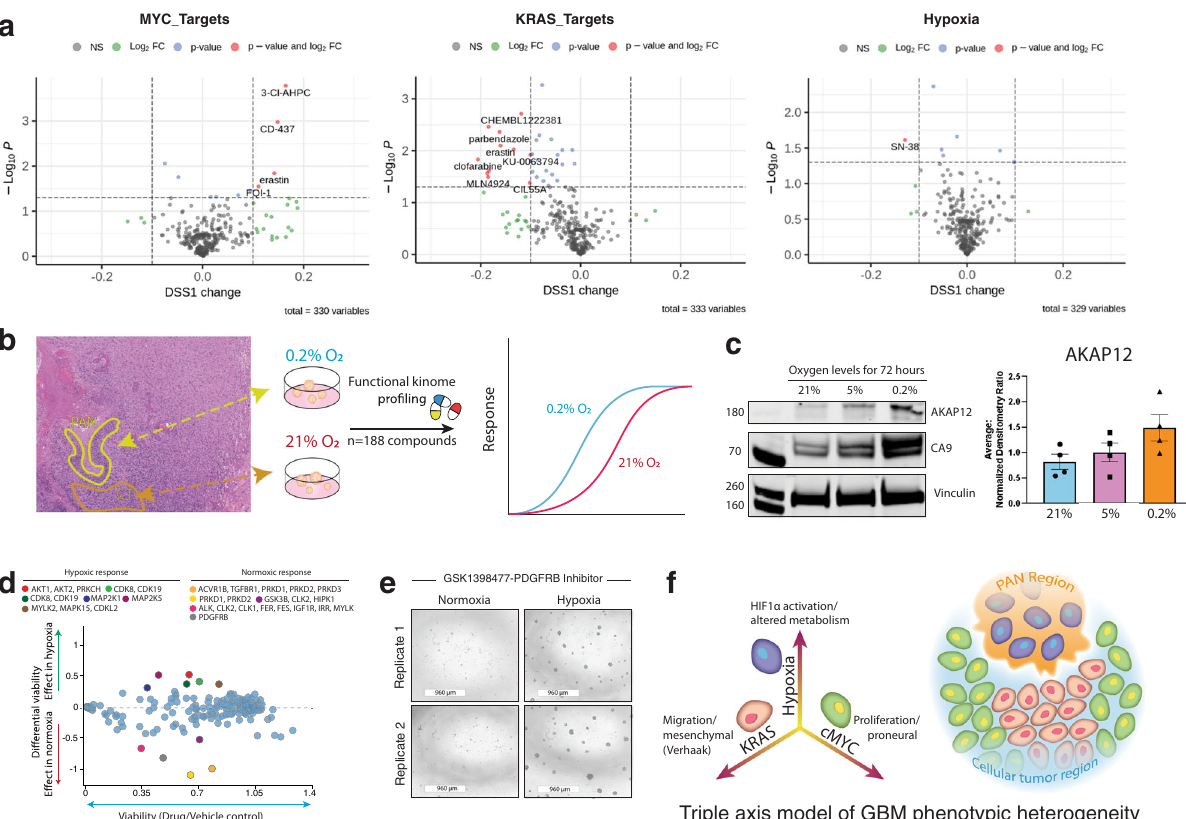
Fig. 6 Pharmacological pro fi ling reveal axis-speci fi c drug vulnerabilities and resistance. a Volcano plots showing pharmacotranscriptomic comparisons of drug sensitivities across cells lines ranking high and low along with the MYC-, KRAS- and hypoxia axis. b Schematic overview of pharmacological pro fi ling of hypoxic and normoxic cell populations to highlight potential differences in drug sensitivities along this axis (left). c Western blots analysis highlights increased CA9 expression with decreasing oxygen levels indicating a downstream response to hypoxia. Relative expression of palisading cells around necrosis (PAN) associated marker AKAP12 by western blot reveals increased expression in hypoxic conditions. Vinculin serves as a loading control. Densitometry analysis of AKAP12 western blots highlights an average 2-fold increase between 21% oxygen and 0.2% oxygen conditions across 4 different cell lines. d Differential viability of hypoxic versus normoxic cell populations (y-axis) upon treatment with 188 compounds and averaged over two replicates, overall cell viability is the average of the cell populations against the reference population (x-axis) and targets with the greatest differential viability are colored by the target as speci fi ed in the top legends. Blue dots represent compounds with the minimal differential response. d Relative viability effects on GSC proliferation in a kinome screen under differential oxygen concentrations. e Spheroid images upon treatment of GSK1398477, a PDGFRB inhibitor, in hypoxic and normoxic conditions. f Model of the heterogeneous co-existence of GBM populations driven by the KRAS or MYC target genes